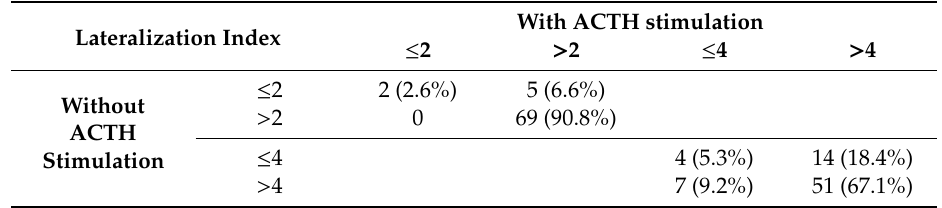
Table 4. Lateralization index comparison in 76 patients with and without adrenocorticotropic hormone (ACTH)